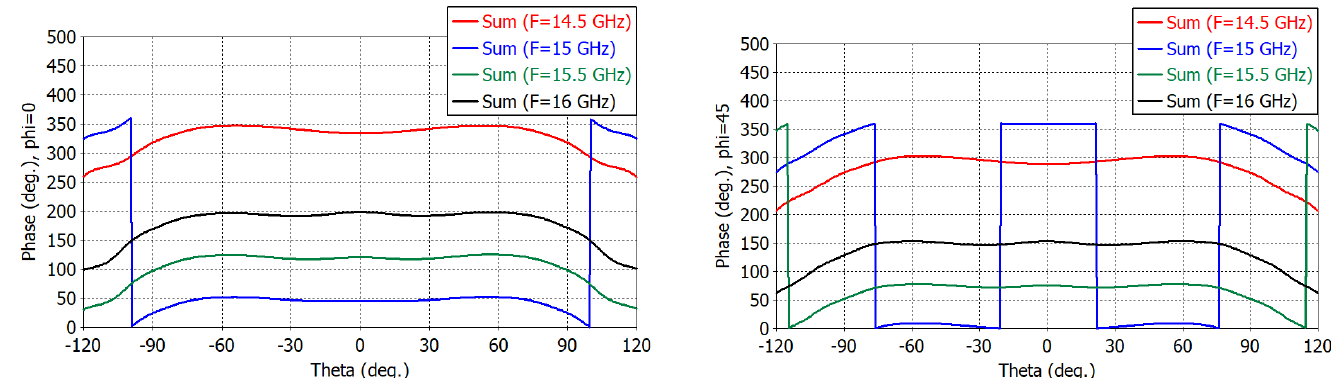
Figure 7. RHCP directivity patterns of the sum channel.